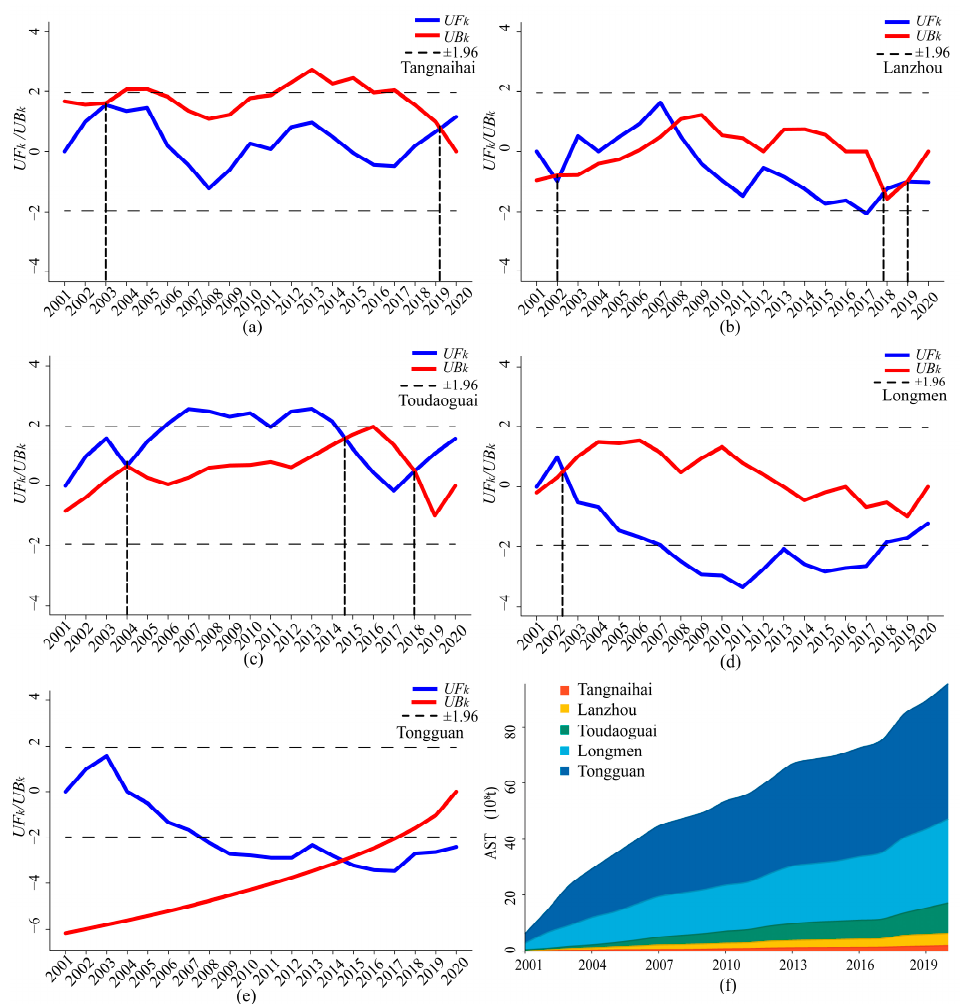
Figure 5. Mann–Kendall mutation test of the AST: URYR ( a – c ), MRYR ( d , e ), and a graph showing the cumulative amount of AST for the five gauge stations ( f ). The abbreviation AST denotes the annual sediment transport. The abbreviations, URYR and MRYR, denote the upper and the middle reaches of the Yellow River,